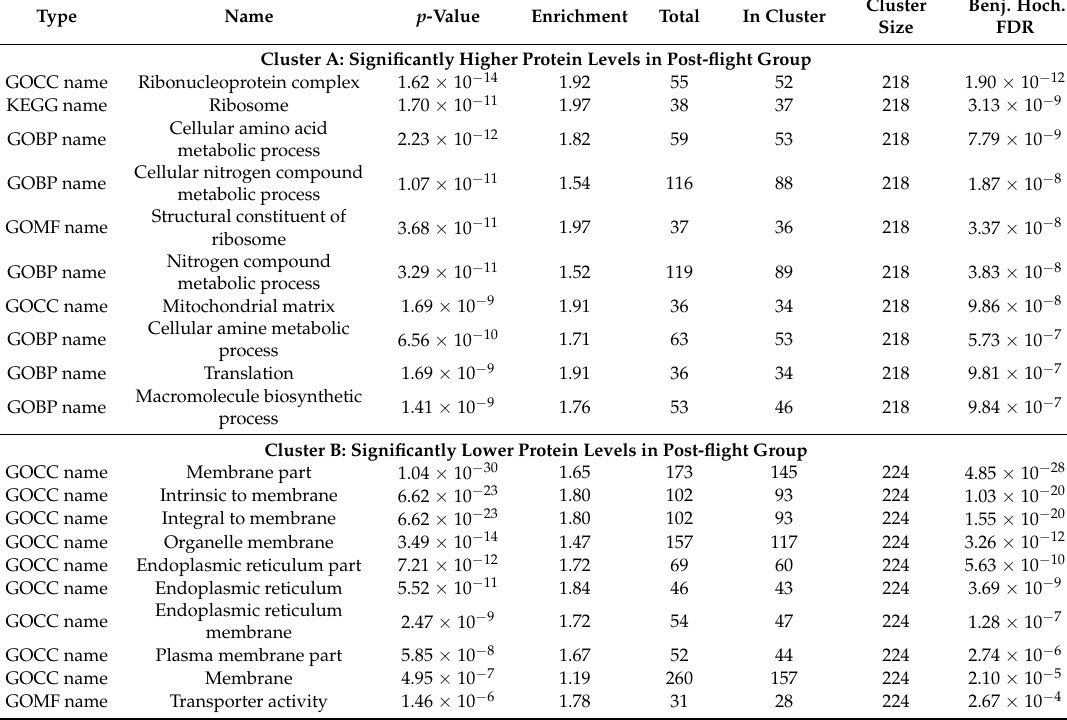
Table 1. Top 10 annotation terms with the highest FDR in enrichment analysis of protein clusters A and B from unsupervised hierarchical clustering. (GOCC = GeneOntology cell compartment; KEGG = Kyoto Encyclopedia of Genes and Genomes; GOBP = GeneOntology biological process; GOMF = GeneOntology molecular